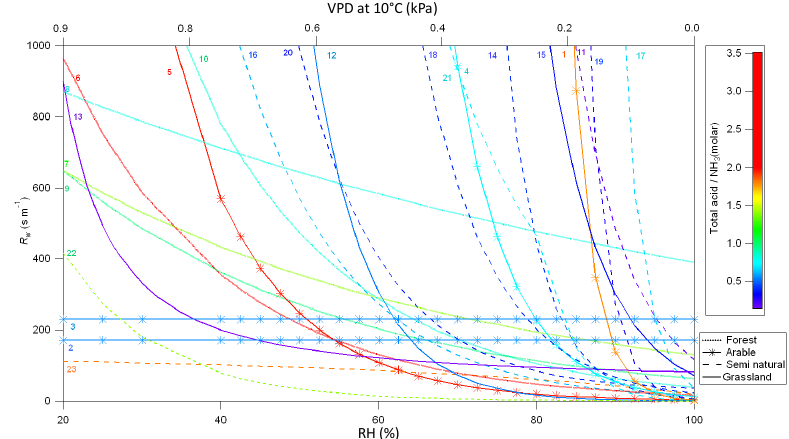
Fig. 2. Compilation of cuticular resistance ( R w ( corr ) ) as a function of relative humidity (RH) at height z 0 separated according to ecosystem type. Dotted lines represent forest ecosystems, short dashed lines represent short semi-natural ecosystems, solid lines represent grasslands and star marked lines represent arable crops. The top x-axis represents the corresponding vapour pressure deficit (VPD) for the primary x-axis at a temperature of 10 ◦ C. Different colours represent the corresponding molar ratio of total acid/NH 3 (AR). Numbers correspond to Table